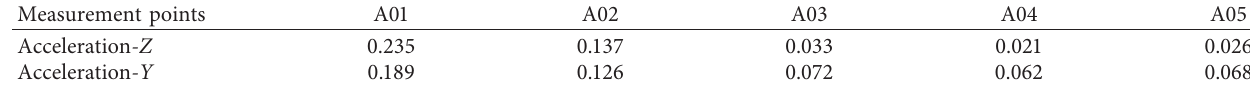
Table 6: Average peak accelerations on the ground surface (unit: m/s 2 ).